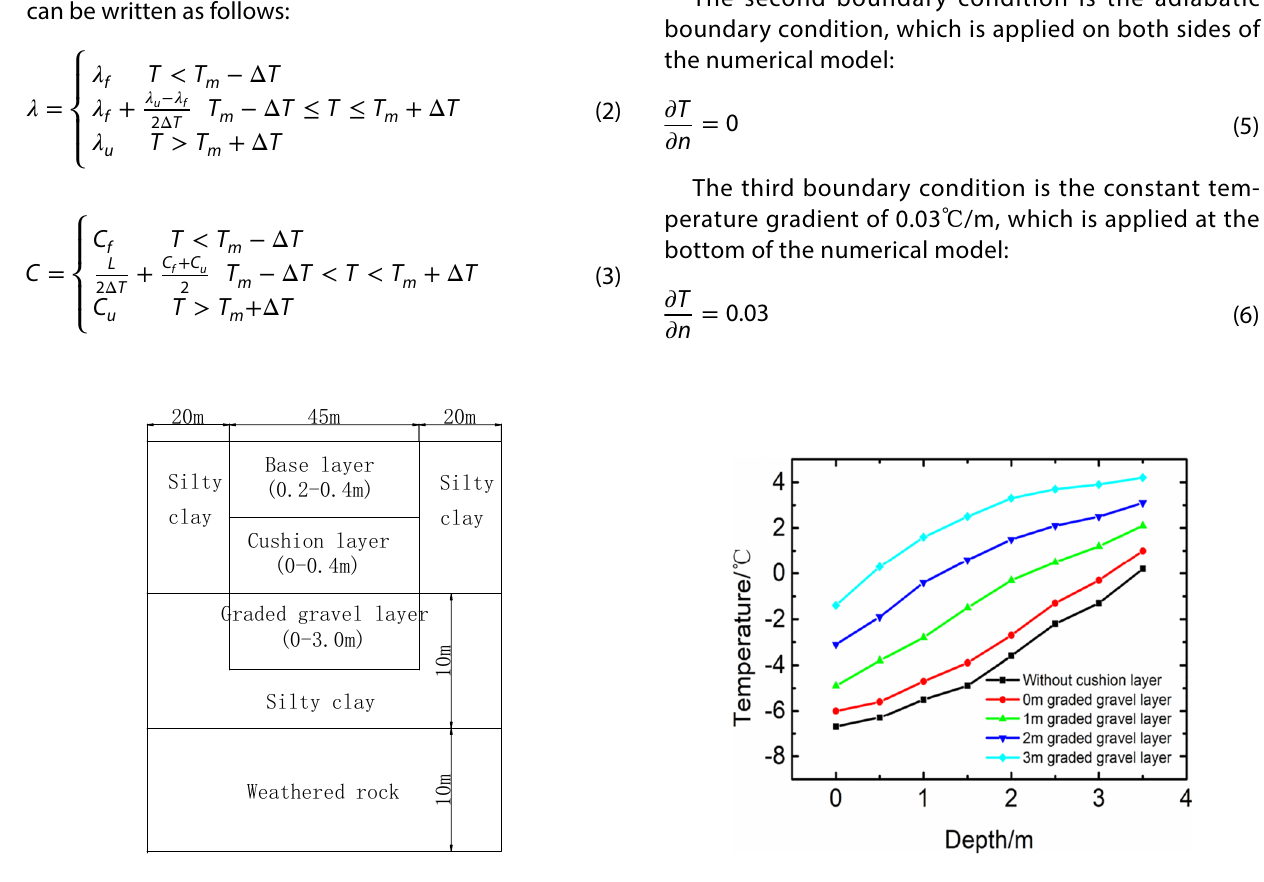
Fig. 1 Schematic diagram of pavement structure and subgrade